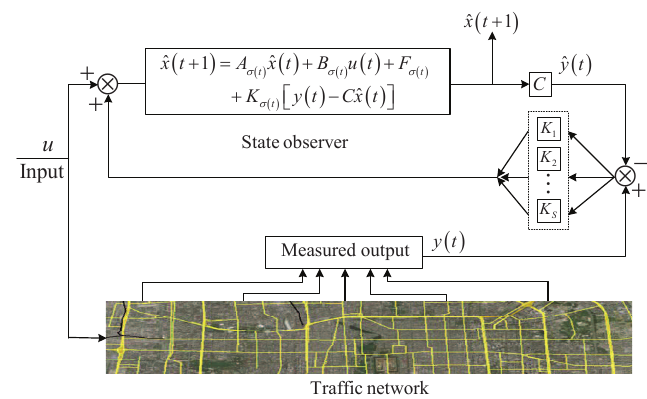
Figure 5. The schematic diagram of state